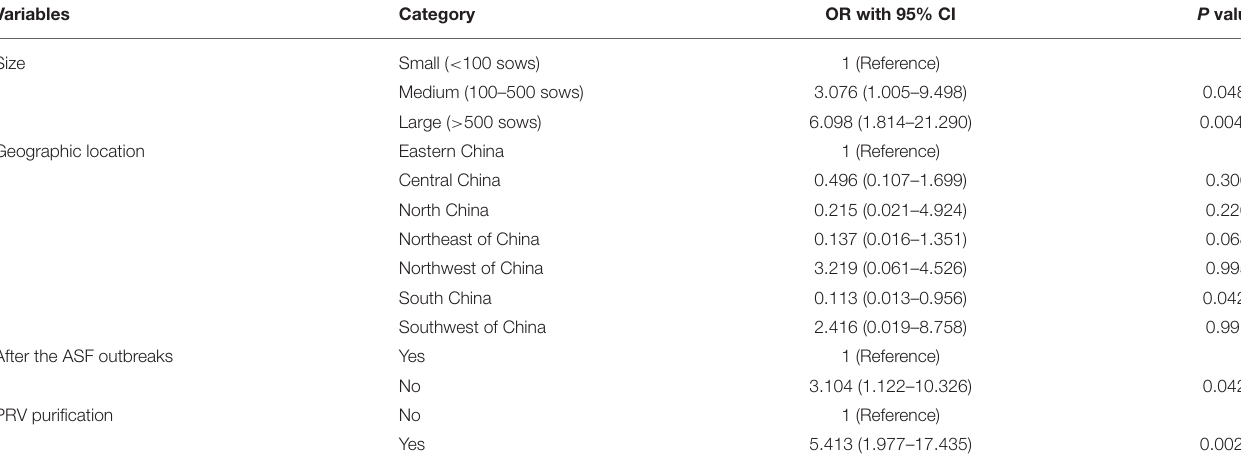
TABLE 4 | Multivariable logistic analysis of risk factors associated with PRRSV serological status of pig farm levels.